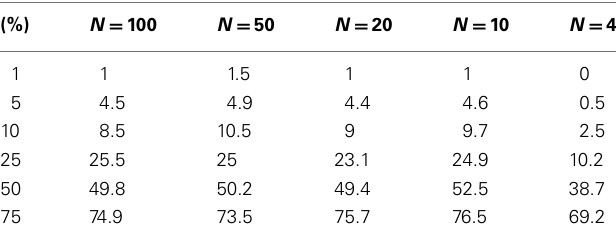
TableA1 | Level accuracy of permutations as a function of decreasing sample size over 1000 Simulations for log normal distribution.